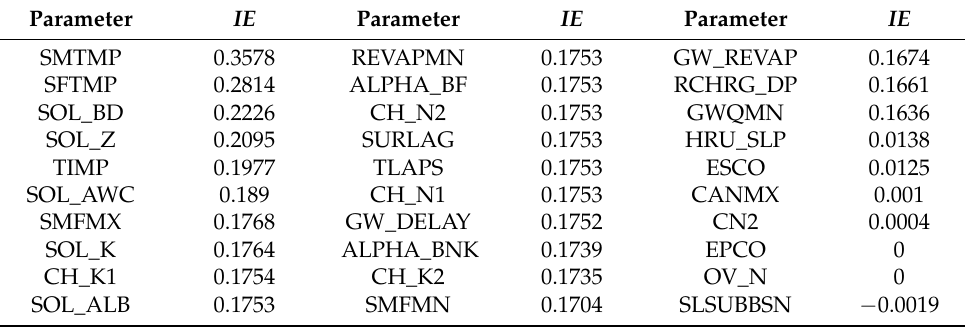
Table 2. Calculation results of the interaction